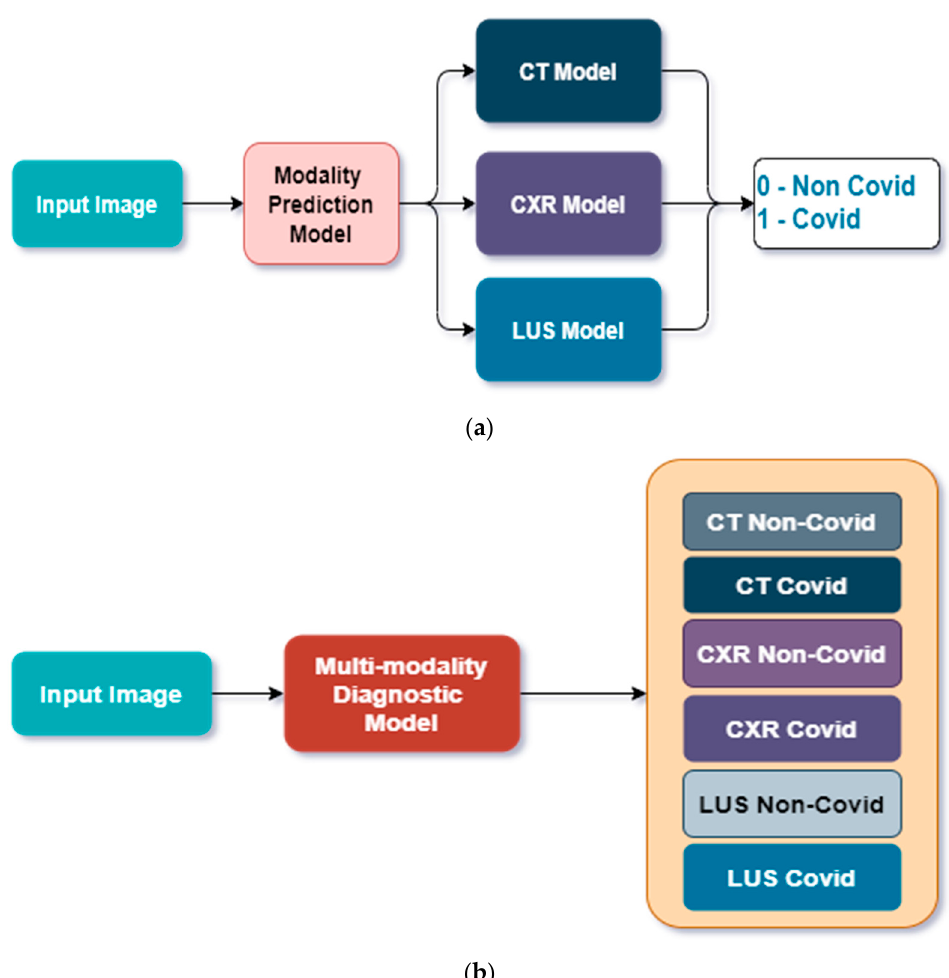
Figure 1. General overview of the methodology. ( a ) Approach 1: A CNN predicts the imaging modality and then passes the image to one of three special CNN models designed for each image mode to predict COVID or Non-COVID diagnosis, ( b ) Approach 2: A single CNN model predicts both image modality and the correct class for each input image.